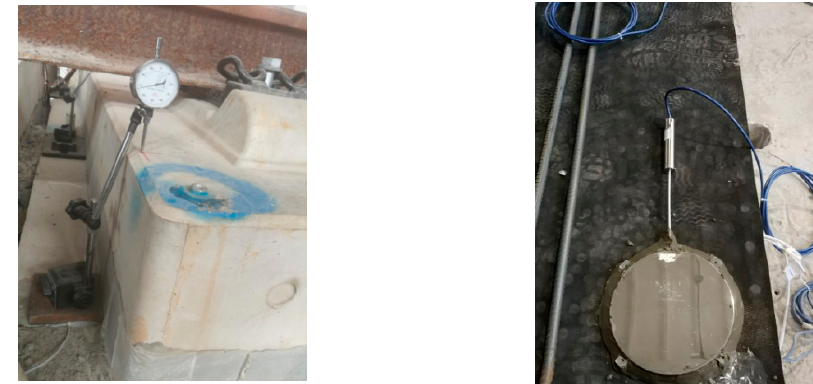
Figure 7. The layout of the ( a ) interlayer deformation and ( b ) interlayer pressure measuring sensors. Ten dial gauges and three pressure measuring sensors were installed on each of the two full- scale ballastless tracks. The ten dial gauges were arranged into five cross-sections on each of the